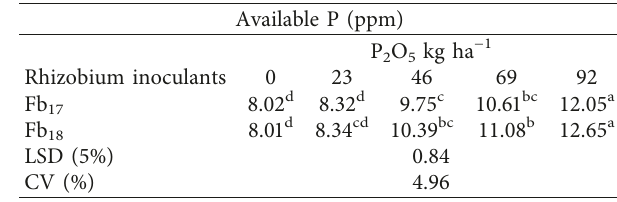
Table 4: The interaction effect of rhizobium inoculation and P fertilizer on soil total N.